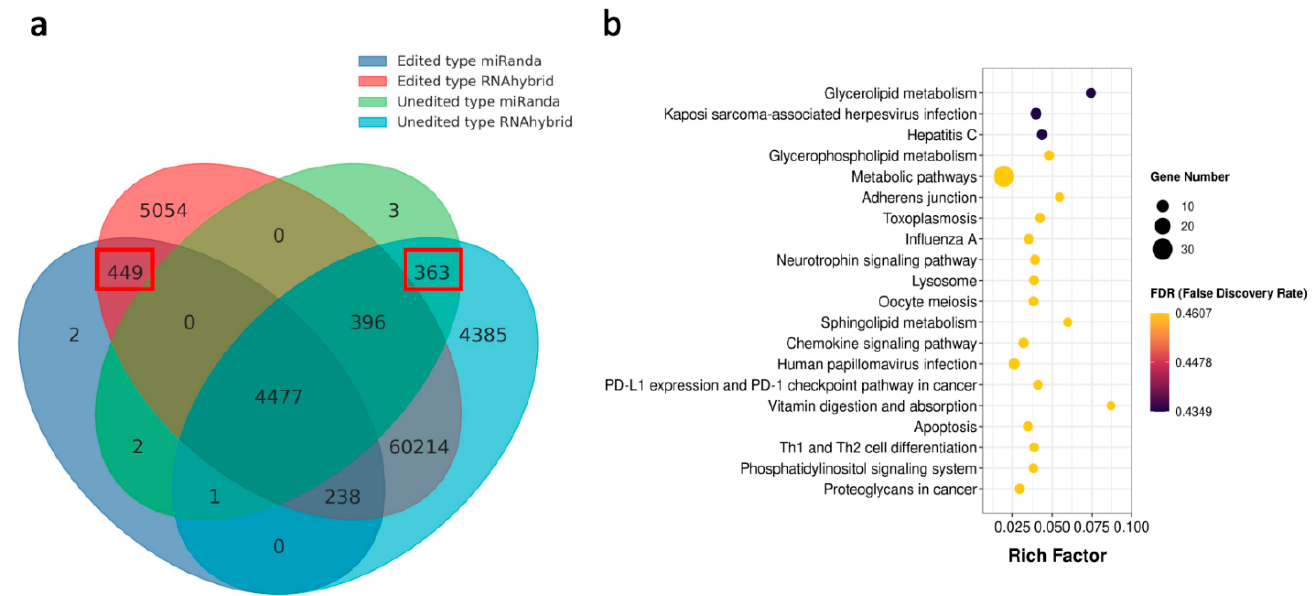
Figure 3. The influence of RNA editing sites on miRNA regulation. ( a ) Overall statistics of the RNA editing sites that altered miRNA binding capacity. The altered interactions are marked with red boxes. ( b ) KEGG enrichment analysis of genes with modified miRNA binding sites. Rich Factor is the ratio of differentially edited gene numbers annotated in this pathway term to all gene numbers annotated in this pathway